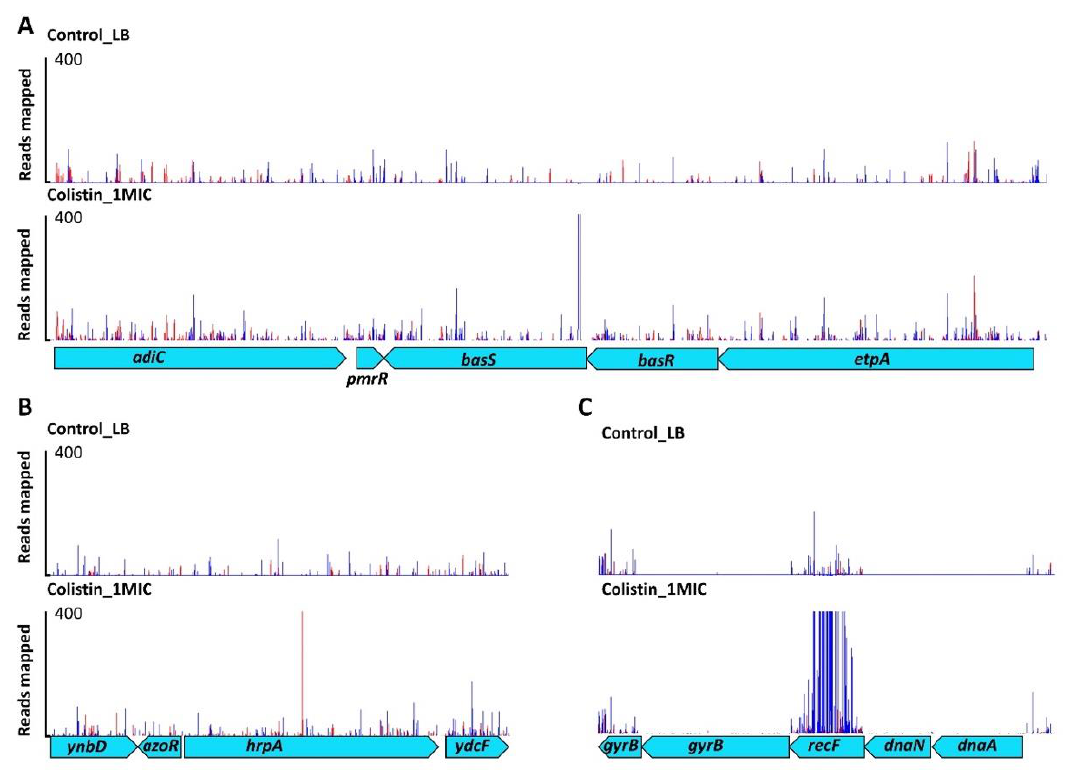
Figure 1. Differential selection and expression of basS , hrpA and recF transposon mutants. Identification of known targets was performed using the TraDIS-Xpress approach incorporating an inducible outward-facing promoter which identifies the impact of both essential and non-essential genes on survival and growth. A genetic map of the relative gene positions is shown at the bottom of the panel. Above this, each row of vertical red or blue lines (plotted with red behind) indicates the position of mapped reads; the height of the bar represents the relative number of reads mapped and the Y -axis scale indicates a scale of 400, representing up to 400 reads mapped in these plots being visible. Red indicates transposon insertions, wherein the transposon-encoded kanamycin resistance gene is oriented 5 ′ to 3 ′ left to right, and blue indicates the opposite (right to left) orien- tation. The top row plot shows untreated control culture and the bottom row is culture grown in the presence of colistin stress. ( Panel A ) shows inserts predicted to result in an up-regulation of basS in the presence of colistin. ( Panel B ) shows the up-regulation of the hrpA domain compared with the control. ( Panel C ) shows the knockout of recF .